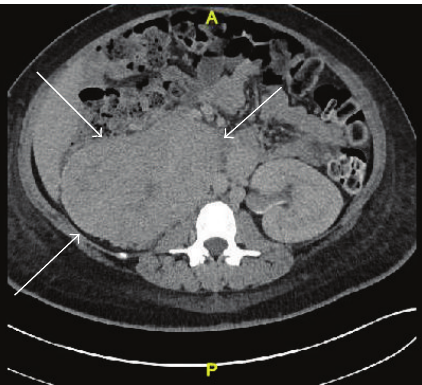
Figure 1: CT scan abdomen/pelvis with contrast showing large retroperitoneal